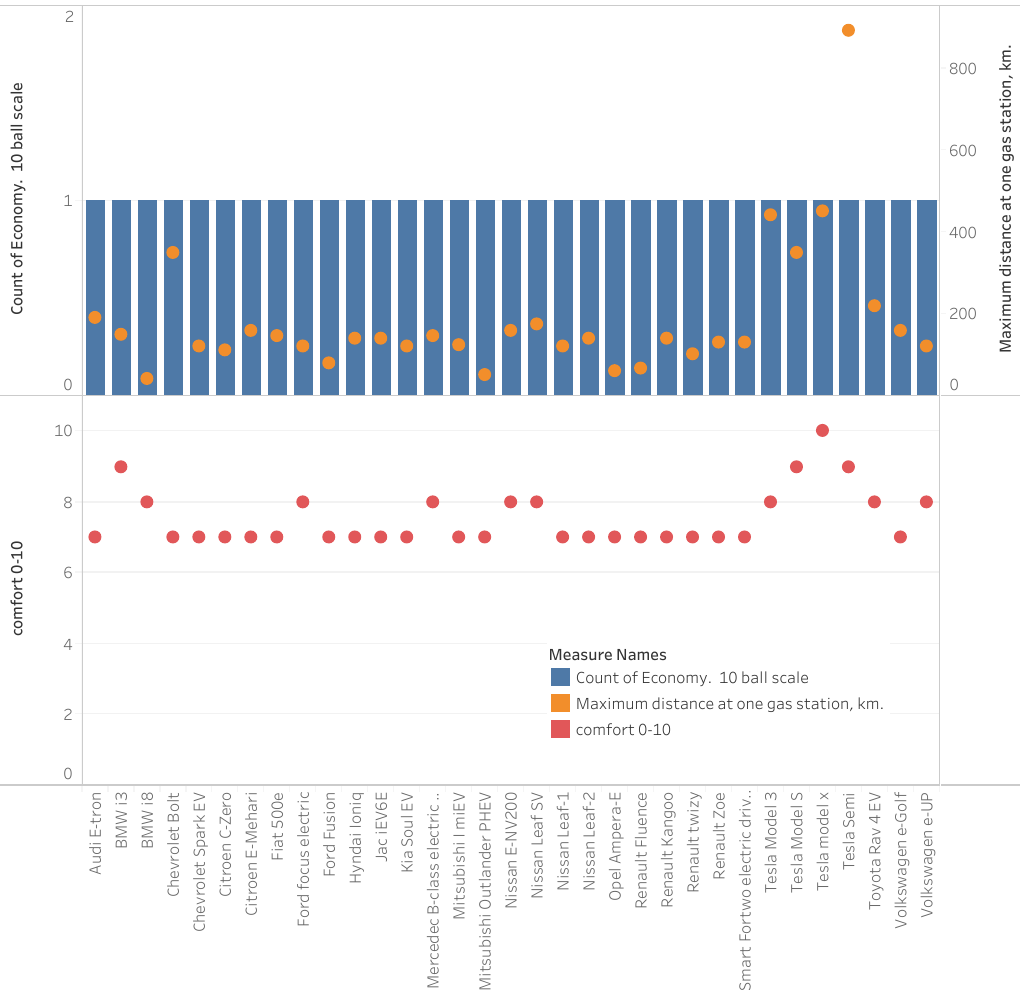
Figure 6. Diagram of correlation between comfort and profitability of